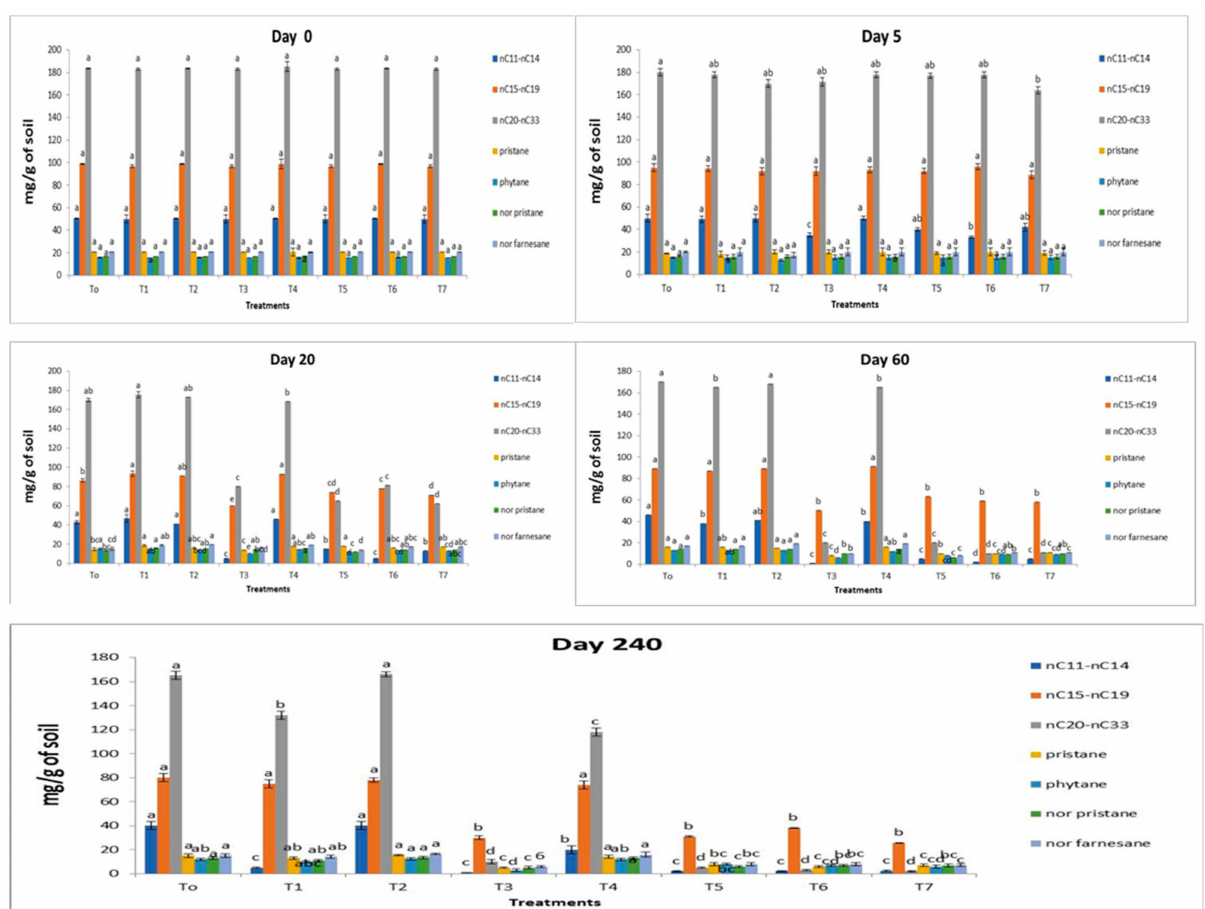
Figure 2. Difference in the rate of degradation of n -alkanes, isoprenoids, pristane, and phytane in untreated (T0) and treated (T1–T7) petroleum waste contaminated soils at different intervals (0, 5, 20, 60, and 240 days) of the incubation period. The data is the comparison among different treatments at different days and all the treatments sharing a common letter are similar otherwise differ significantly at p <